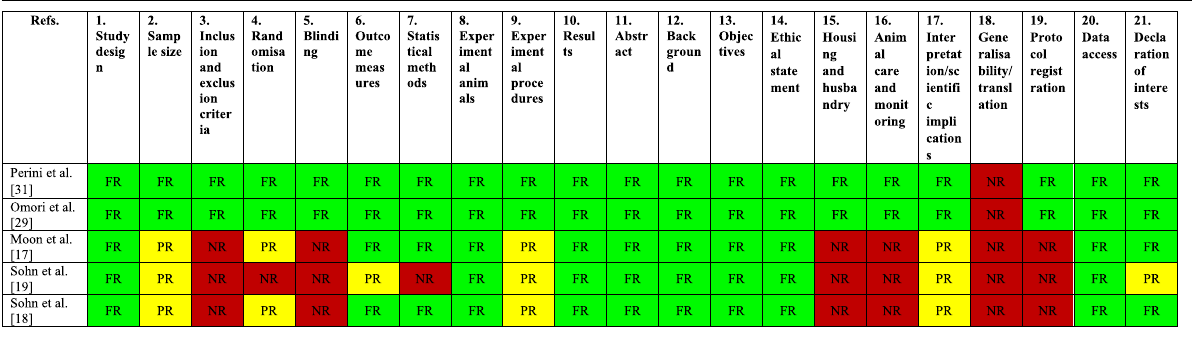
Table 4 Quality assessment of the included in vivo animal studies using ARRIVE